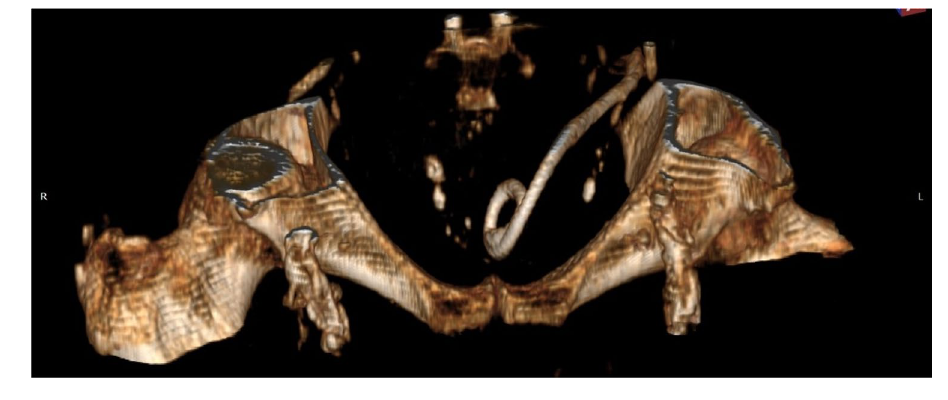
Fig. 7 Control pelvic ultrasound showing complete resolution of the collection (arrow) and the catheter in place within the emptied cavity (open